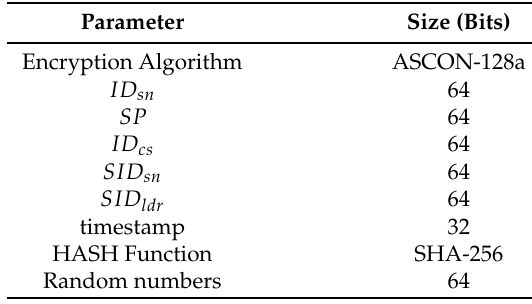
Table 4. Simulation